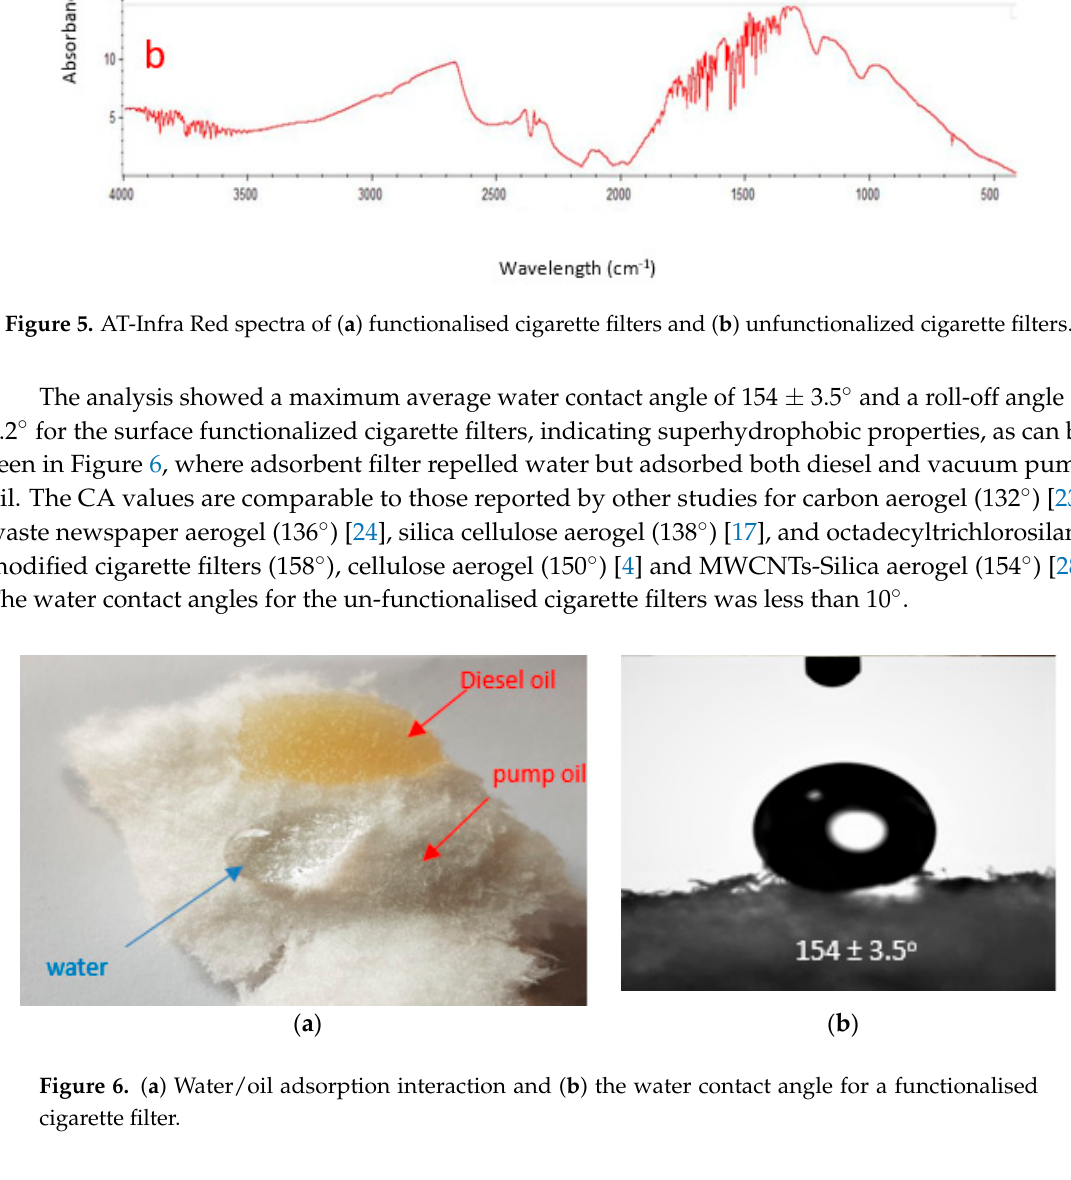
Figure 7. Selective adsorption schematic by sorbents. ( a ) Water and oil; ( b ) water oil and adsorbent filters.